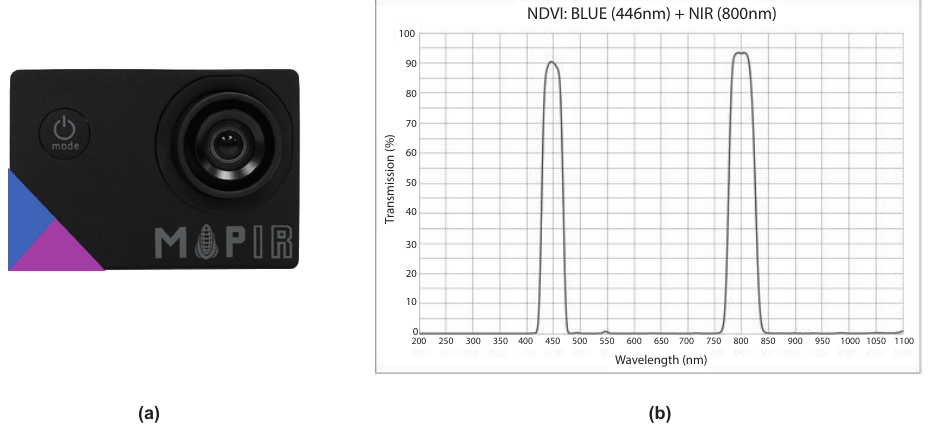
Figure 8. MAPIR Survey1 camera © ( NDVI BLUE + NIR ) ( a ) blue light and infrared wavelengths ( b ). Table 1. MAPIR Camera technical specifications